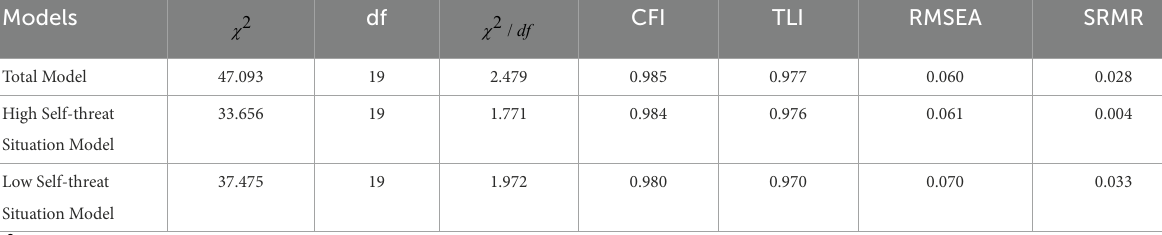
TABLE 4 Structural equation model confirmatory factor analysis.